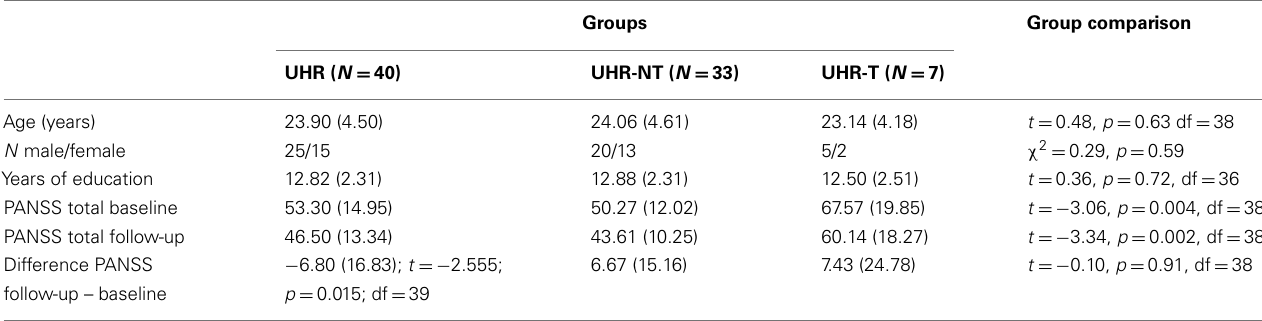
Table 1 | Demographic and clinical variables by group